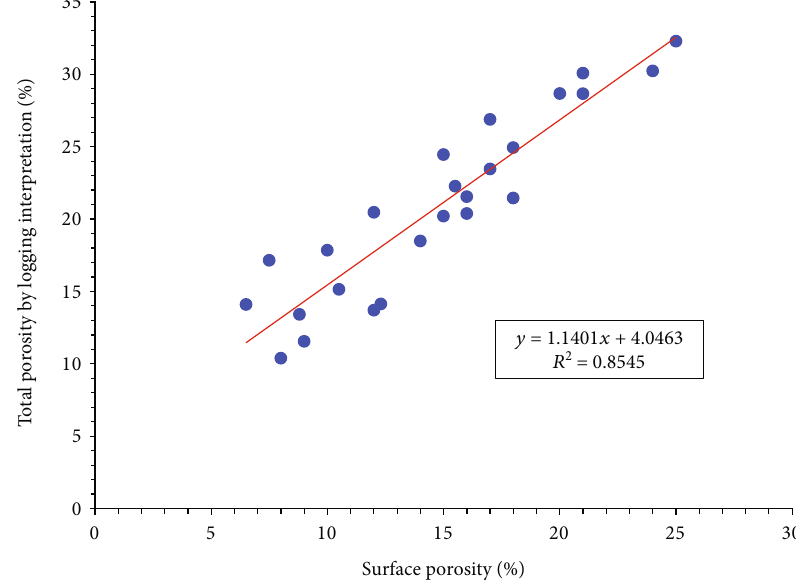
Figure 7: Relation between surface porosity and total porosity by logging (Table 3). The remaining 9 cores are used for method veri fi - cation and accuracy analysis.